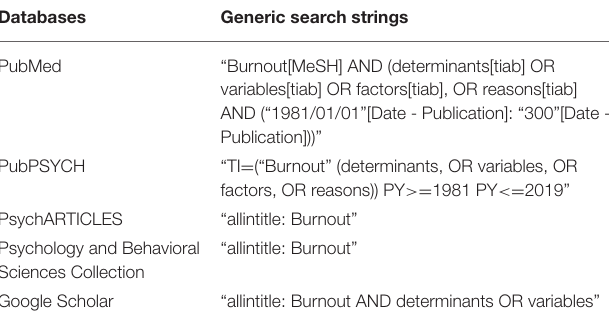
TABLE 1 | Used databases and generic search strings.